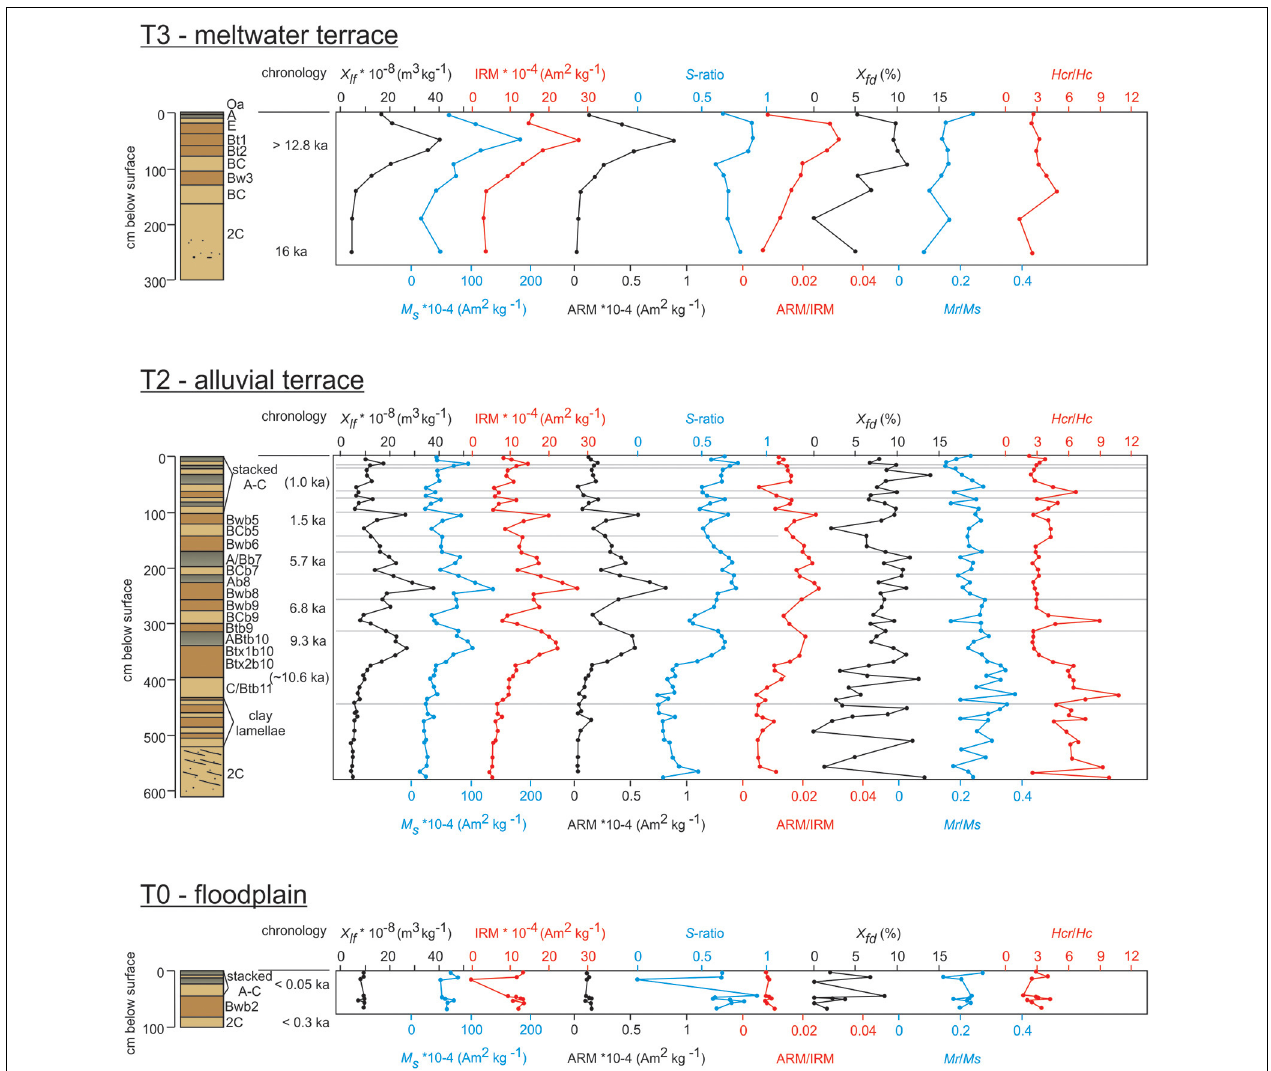
FIGURE 3 | Magnetic characterization results for the T3, T2, and T0 profiles. The T3 soil began forming after 16kyrs BP, but before 12.8kyrs BP based on a late Pleistocene buried soil recorded at the base of some T2 profiles (Gingerich, 2013). The 10.6ka age from